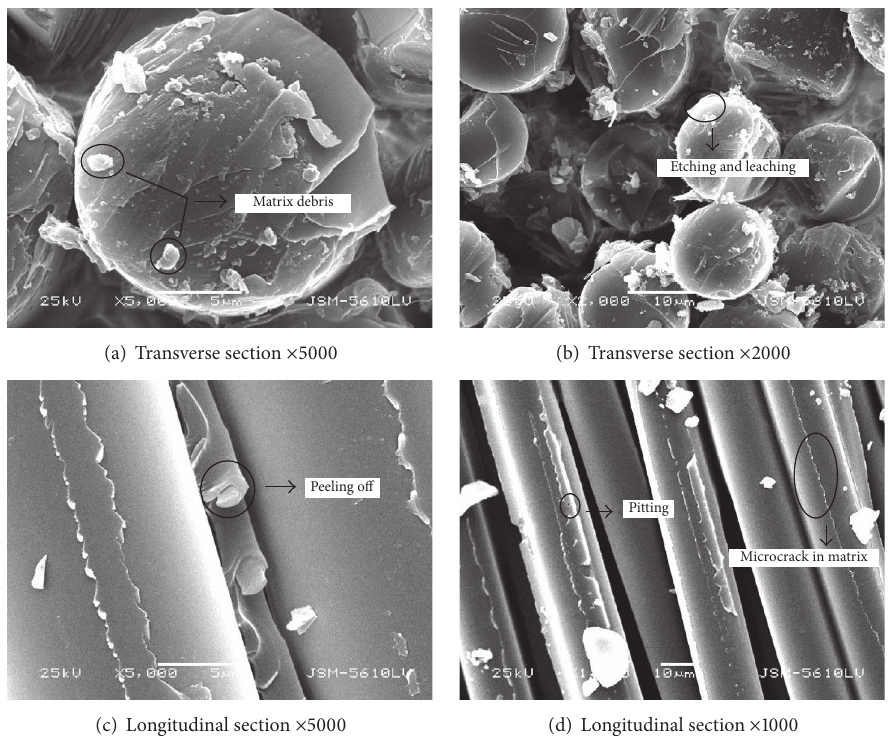
Figure 2: Microstructure morphology of GFRP bars in the standard-curing